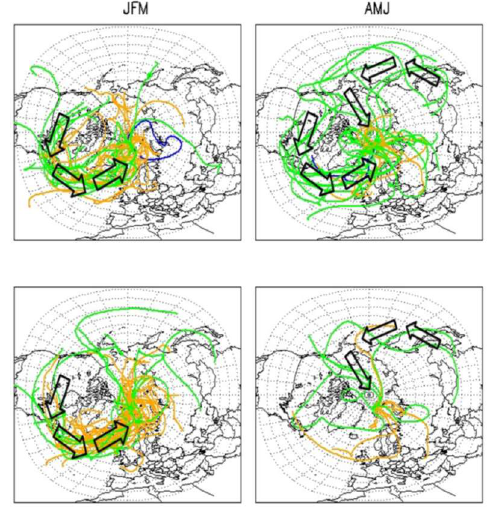
Fig. 4: Backward trajectories for desert dust (upper panel), and polluted dust (lower panel) subtypes in the periods of January to March 2015 (JFM, left) and April to June 2015 (AMJ, right). The color of the trajectories indicates the arrival altitude in the high Arctic: orange 2–5 km, and green 5–10 km). The arrows show principal transport